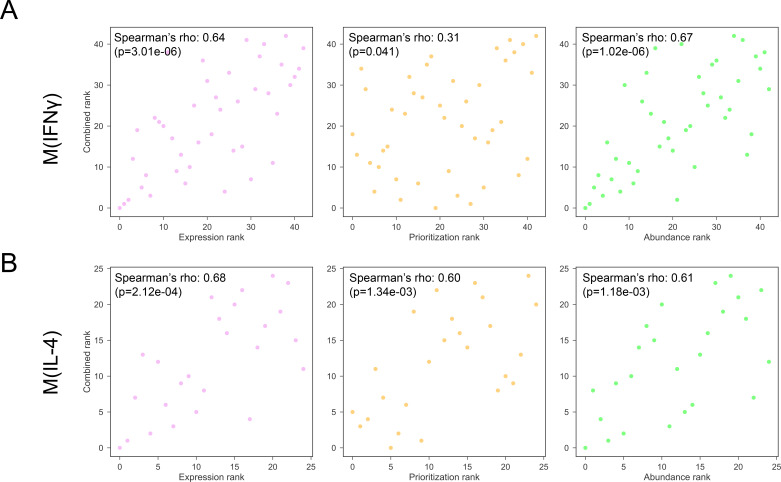
(A) The Spearman’s correlation of combined ranking with each constituent ranking, that is gene expression, network prioritization, and protein abundance, respectively, for M(IFNγ). (B) The Spearman’s correlation of combined ranking with each constituent ranking, that is gene expression, network prioritization, and protein abundance, respectively, for M(IL-4).